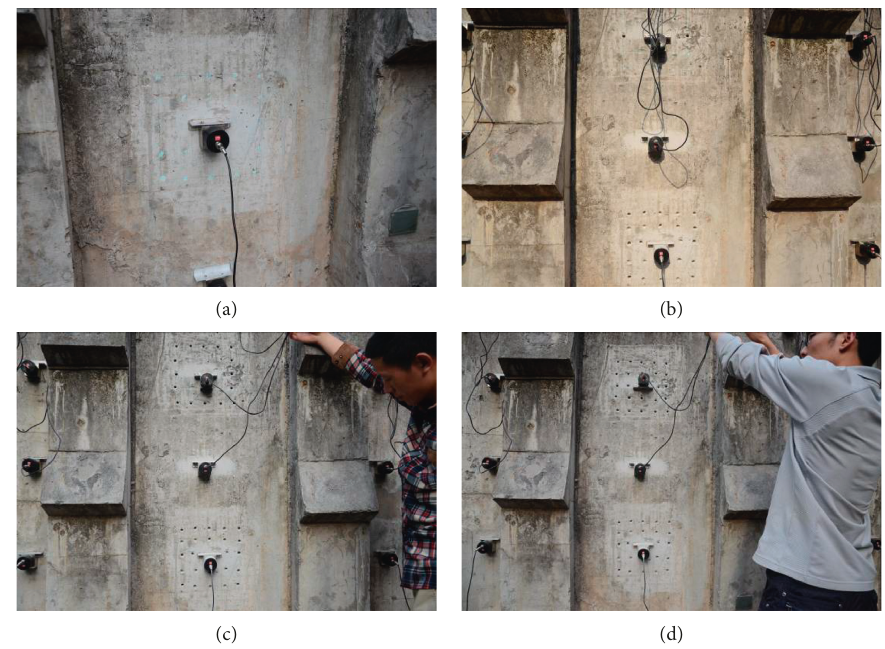
Figure 13: Partial damages in model tests (two damages). (a) Case 1. (b) Case 3. (c) Case 6. (d) Case